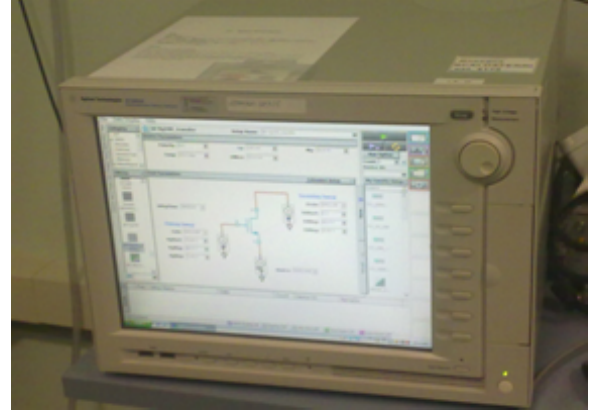
Figure 10. Semiconductor device analyzer.